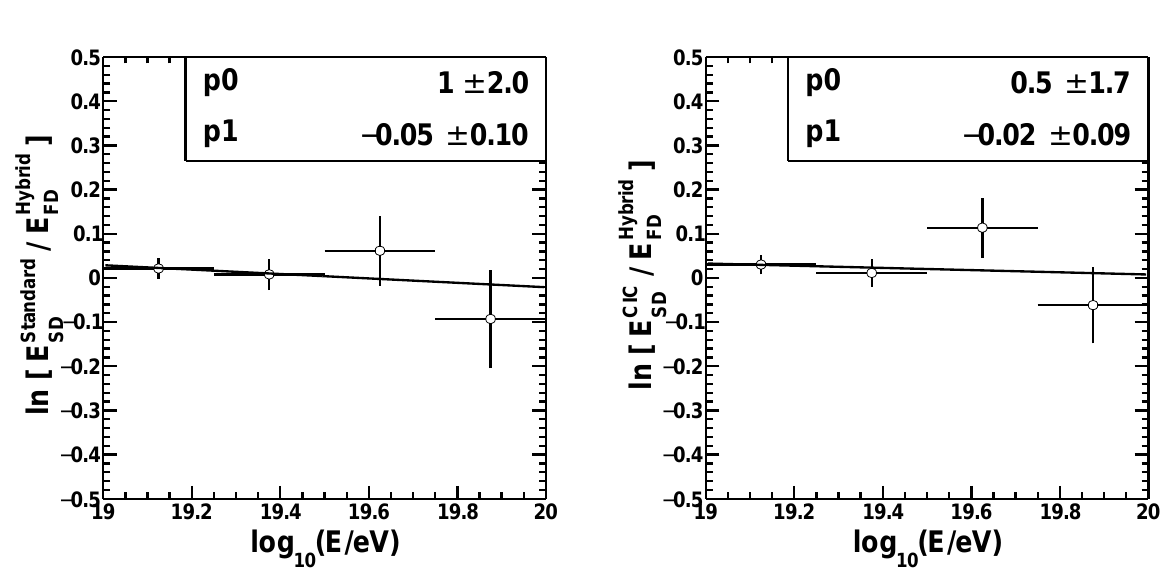
Figure 7. Natural logarithm of the energy reconstructed by the TA SD and the energy reconstructed by the TA FD for the (hybrid) events that have been seen both by the TA FD and SD in common, plotted versus the logarithm of energy. The left panel shows the SD and FD energy comparison for the standard, Monte Carlo-based reconstruction of the TA SD energy, and the right panel shows the same for the constant intensity cut (CIC) reconstruction of the TA SD energy. Fits to the straight lines yield slopes that are well within their fitting uncertainties.